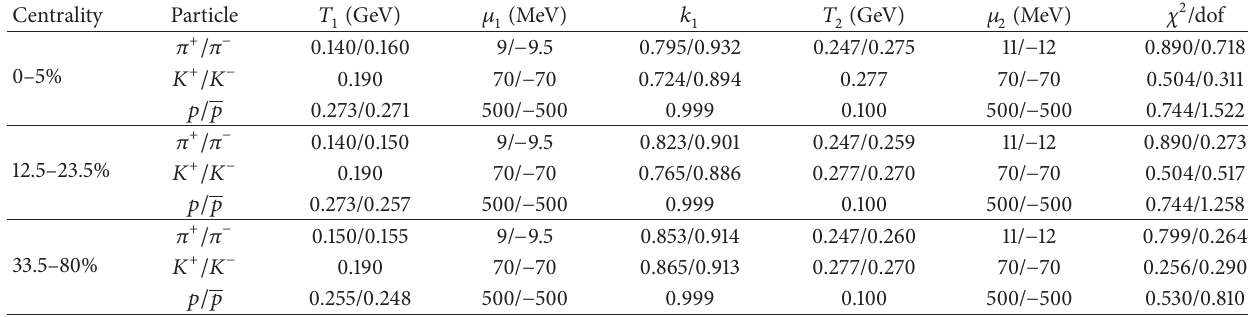
Table 3: Parameter values corresponding to the dashed curves in Figure 1. The relative errors for the effective temperatures, chemical potentials, and ratios are about 5%, 10%, and 3%, respectively. The values for positively/negatively charged particles are given in terms of /value ” in the case of the two values being different. “value 1 2